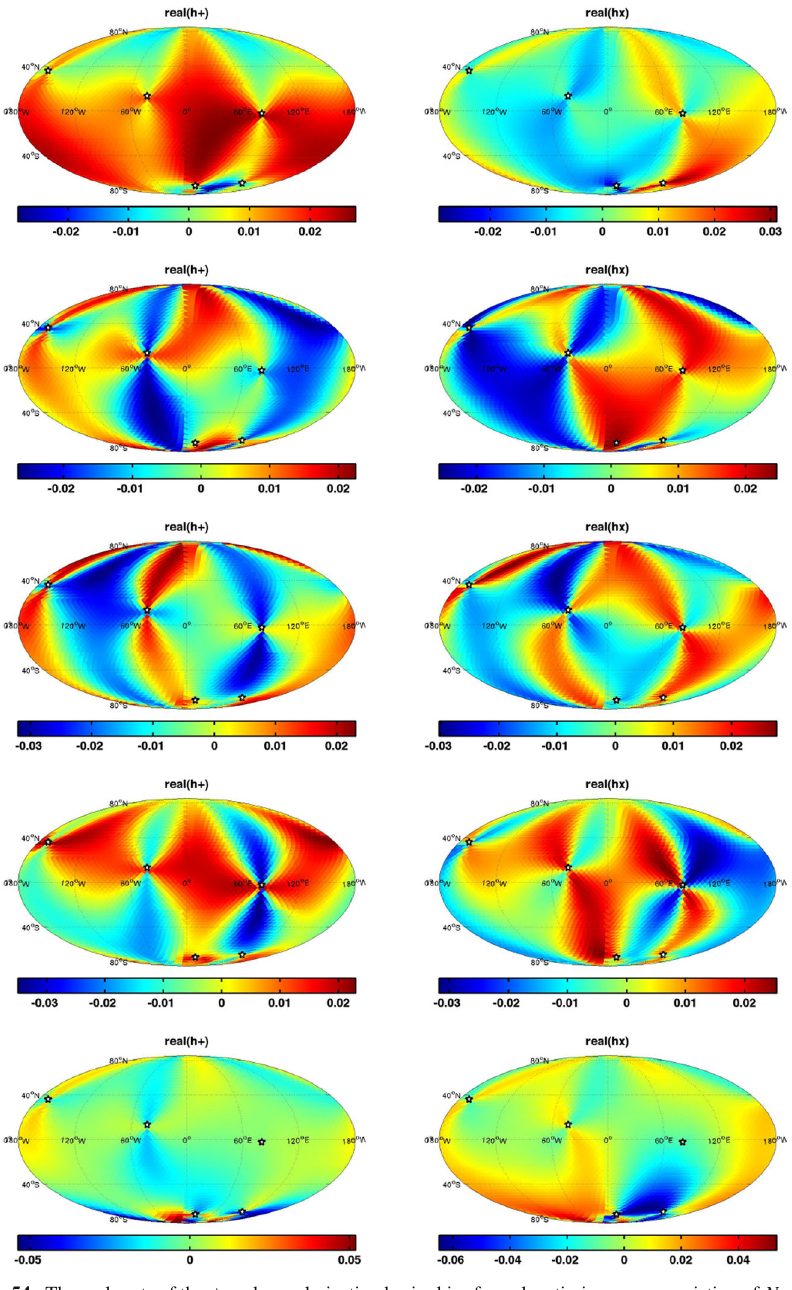
Fig. 54 The real parts of the + and × -polarization basis skies for pulsar timing array consisting of N = 5 pulsars randomly distributed on the sky. The imaginary components of the basis skies are identically zero. The basis skies are shown in decreasing size of their singular values, from the top of the figure to the